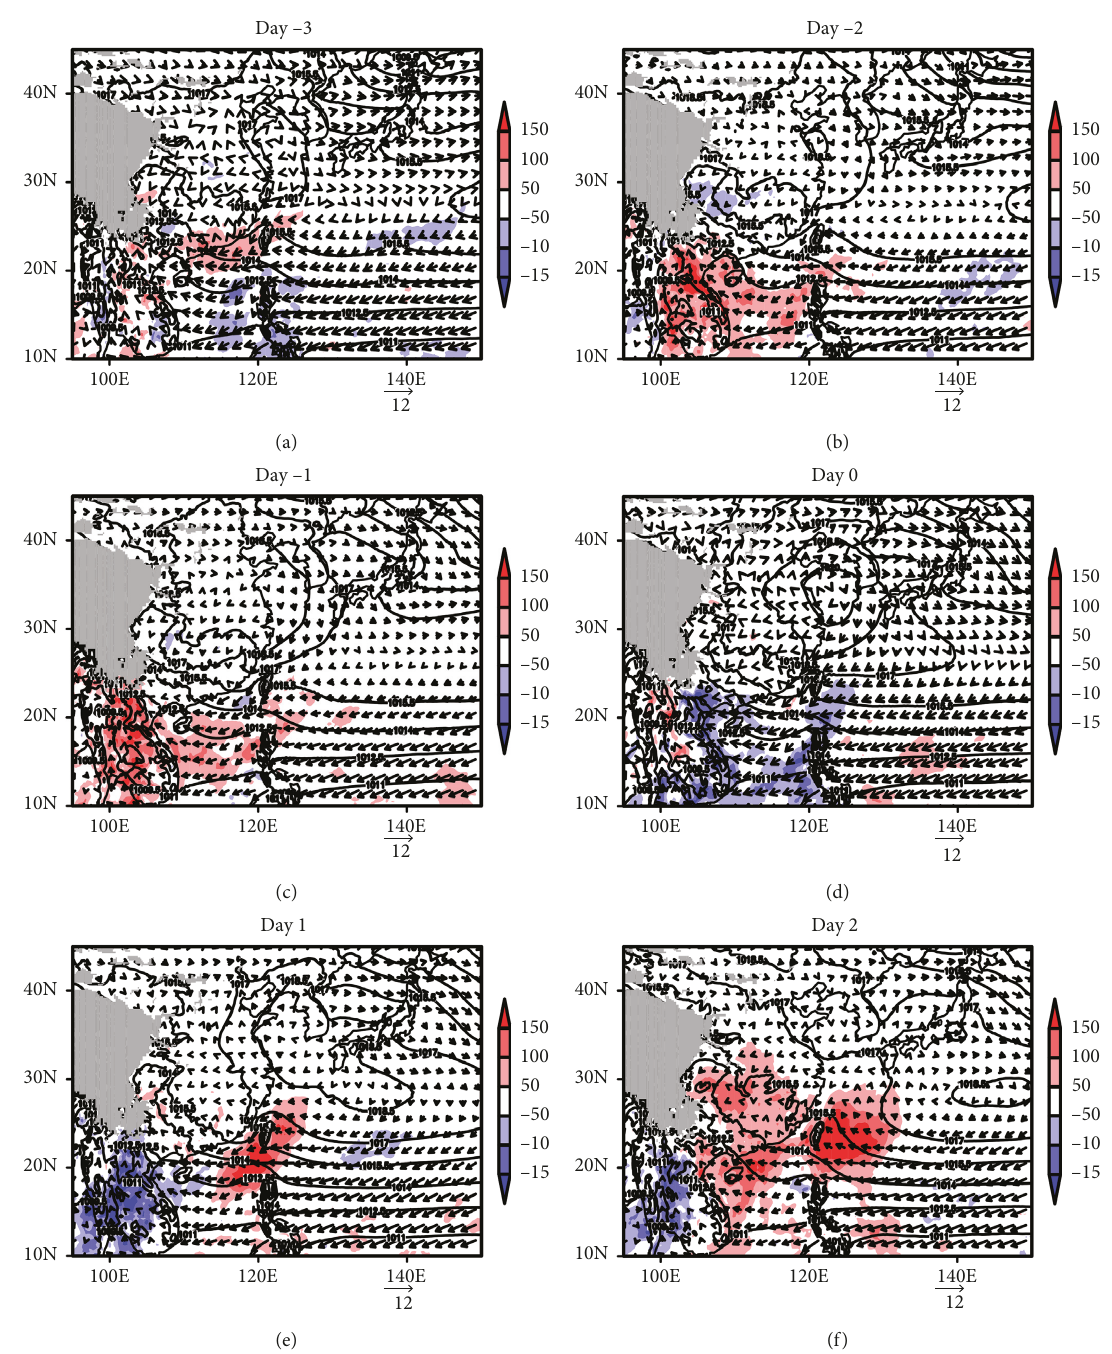
Figure 12: Same as Fig. 7, except for during the events associated with cold surge and upper-level